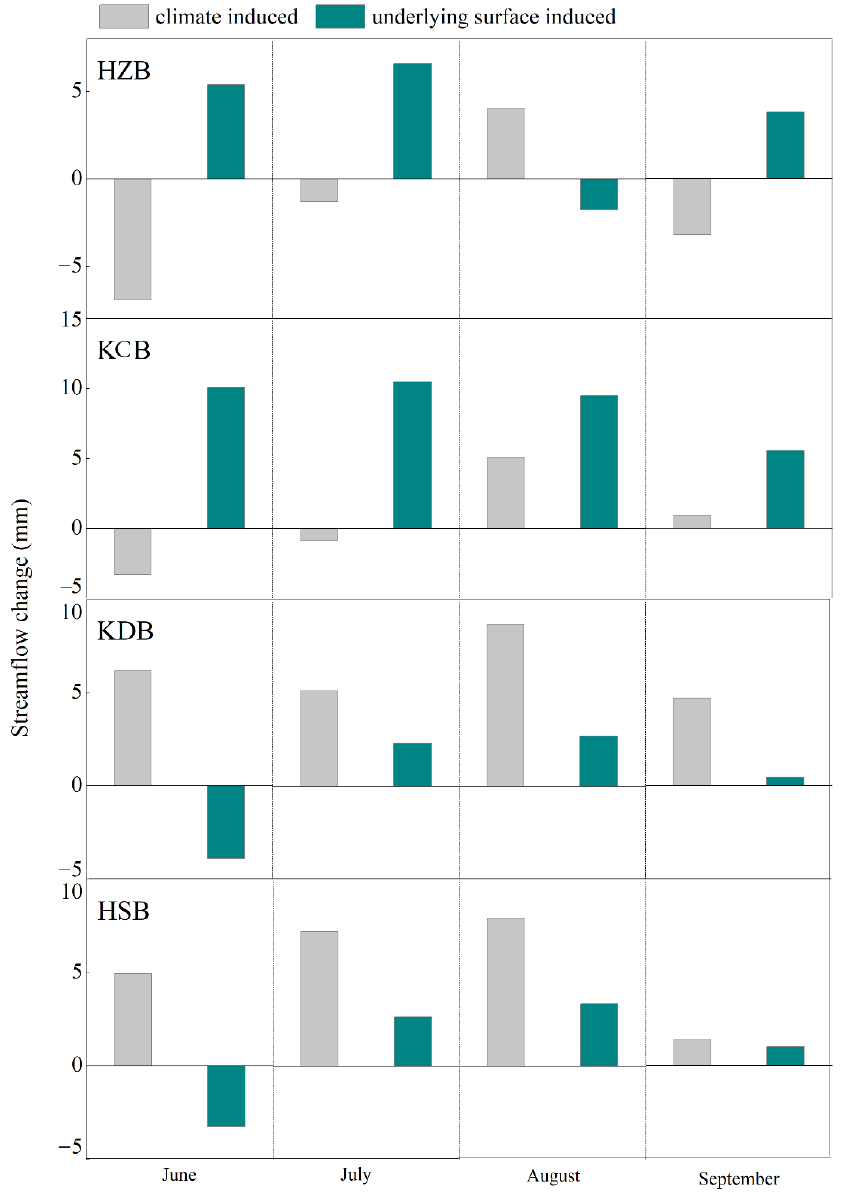
Figure 8. Quantification results of the climate-induced and underlying surface-induced changes in streamflow for the four basins during each summer month. streamflow for the four basins during each summer